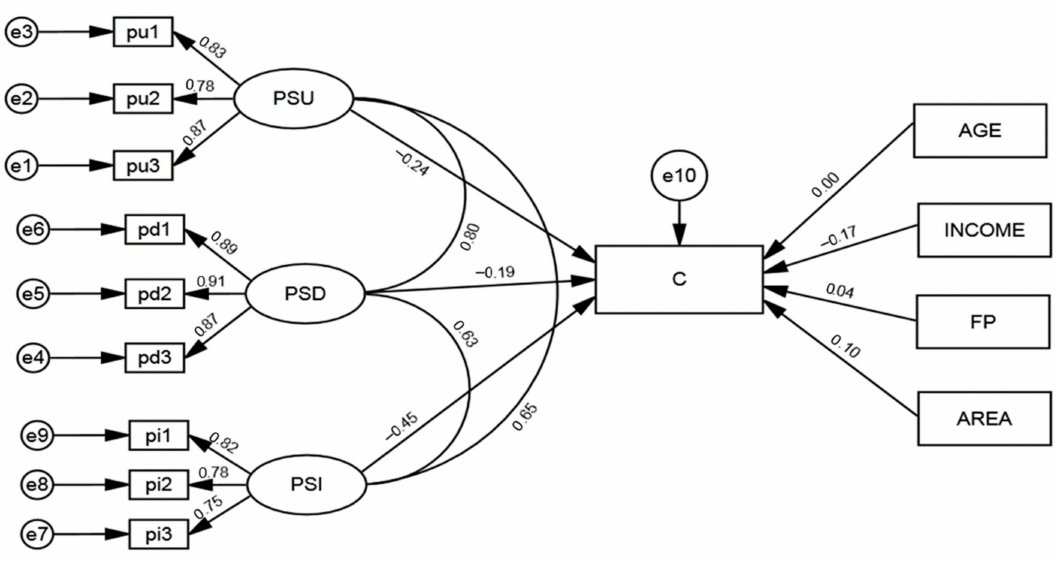
Figure 4. Total effect